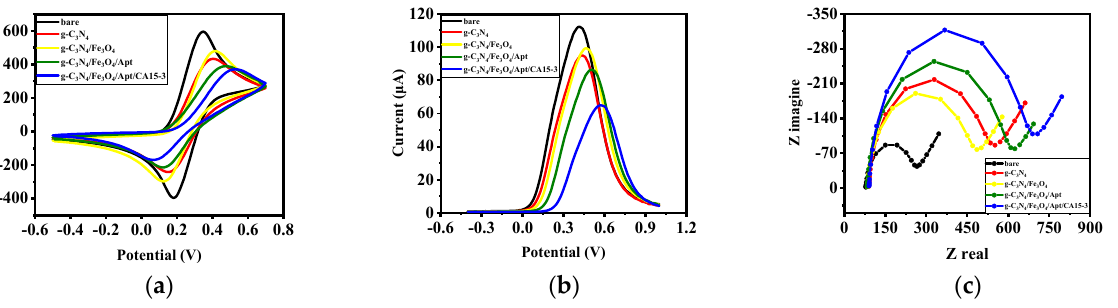
Figure 2. Electrochemical characterization of the developed nanobiosensor by ( a ) CV analysis, ( b ) SWV analysis and ( c ) EIS analysis of the bare electrode and each step of the preparation of the modified electrodes in K 4 [ Fe ( CN ) 6